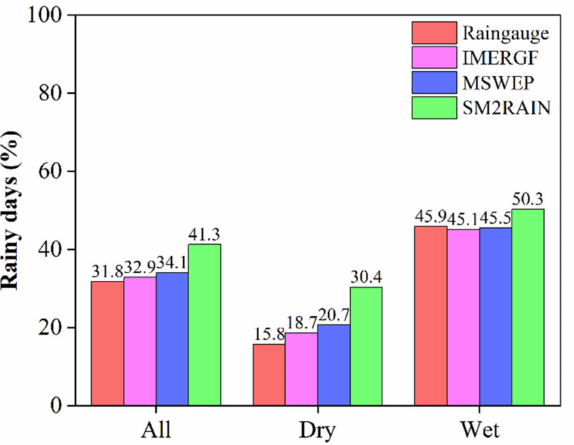
Figure 8. Rainy days (%) derived from SPPs and rain gauges for seasonal and annual